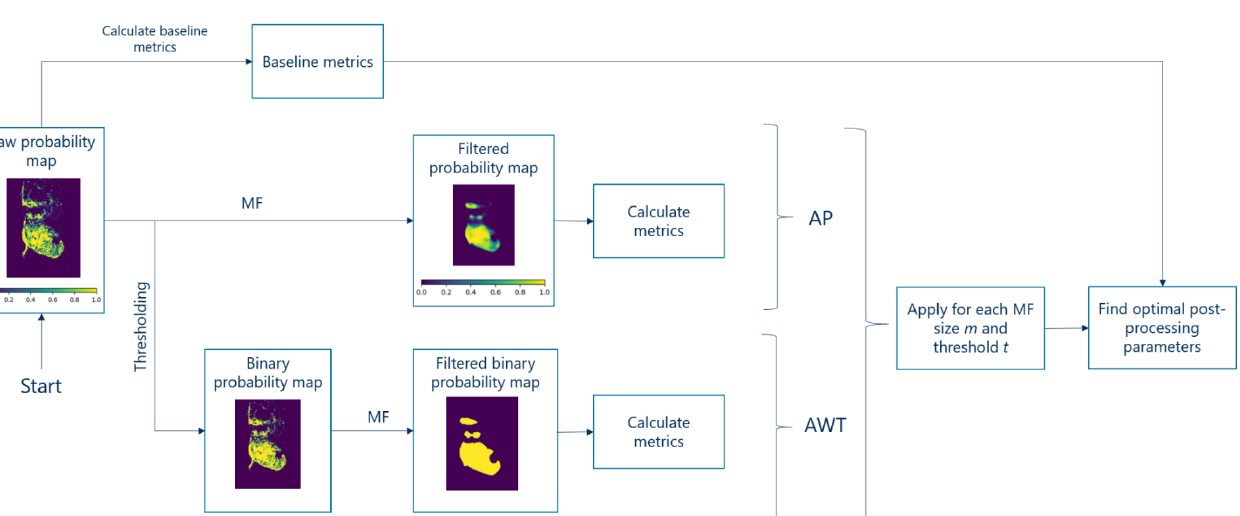
Figure 7. Prediction map examples in the left column and ground truth annotated by physicians on the right side, with the correspondence between colors and output probabilities shown on the color bar. Yellow represents cancerous tissue, purple non-malignant tissue, and red the margin of the cancer.